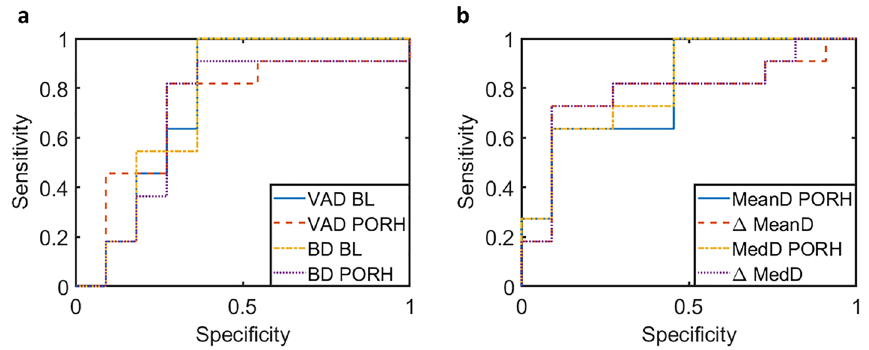
Figure 4. Representative ROC curves for selected metrics from the logistic regression analysis in the hand ( a ) and the foot ( b ). VAD vessel area density, BD branchpoint density, MeanD mean diameter, MedD median diameter, PORH post occlusive reactive hyperaemia, BL baseline. Area under the ROC curves for the metrics presented here are as follows (with 95% confidence interval): hand VAD BL—0.752 (0.528:0.977); hand VAD PORH—0.719 (0.487:0.951); hand BD BL—0.752 (0.528:0.977); hand BD PORH—0.702 (0.464:0.945); foot MeanD PORH—0.802 (0.613:0.990); foot ΔMeanD—0.785 (0.578:0.992); foot MedD PORH—0.818 (0.640:0.997); foot ΔMedD—0.777